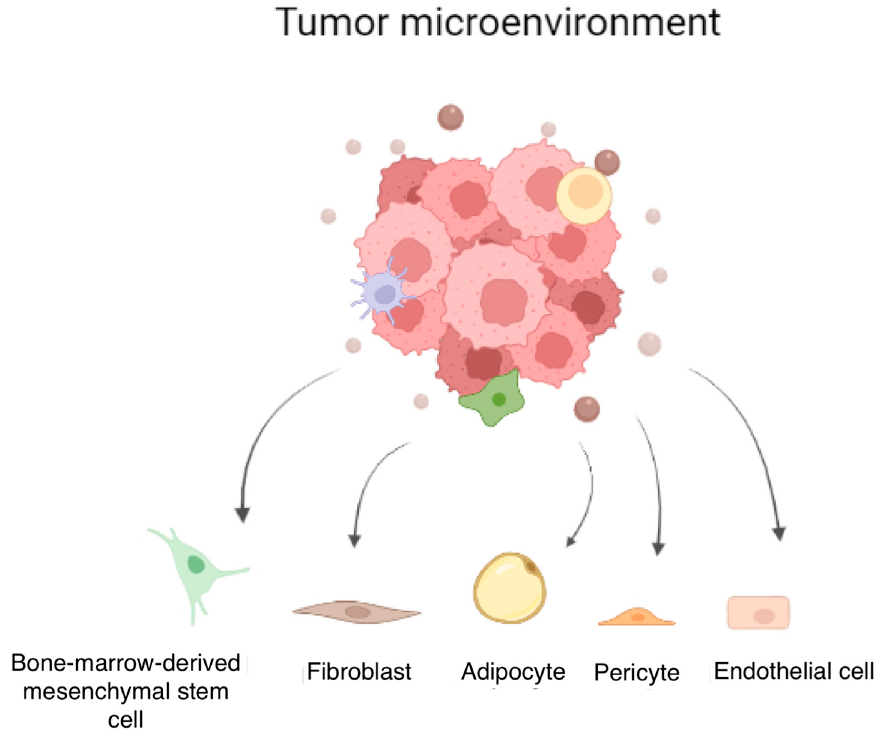
Figure 3. Potential sources of CAFs. In PCa, TME interacts with proximal and distal cells, such as bone-marrow-derived mesenchymal stem cells, healthy fibroblasts, adipocytes, pericytes, and endothelial cells, inducing the switch into CAFs. CAFs build paracrine communication with cancer cells by releasing factors, such as IL-6, IL-8, TGF β , FGFs, VEGF, and GDF15, stimulating tumor growth, angiogenesis, and progression.